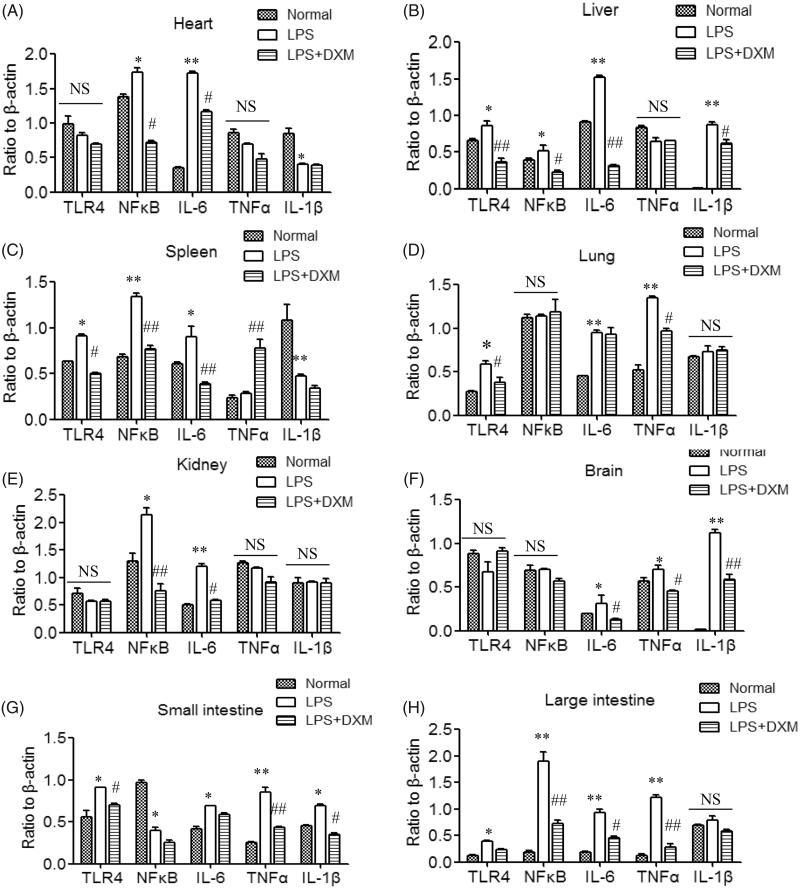
Protein expression of the TLR4/NFκB signalling pathway in the major organs of mice after intravenous administration of LPS. DXM was used as 0.5 mg/kg. Data are presented as the mean ± SD (9 mice in the normal group, 15 mice in the LPS group and 14 mice in the LPS + DXM group). *p < 0.05 or **p < 0.01 vs. normal group. #p < 0.05 or ##p < 0.01 vs. LPS group. NS: no significance.